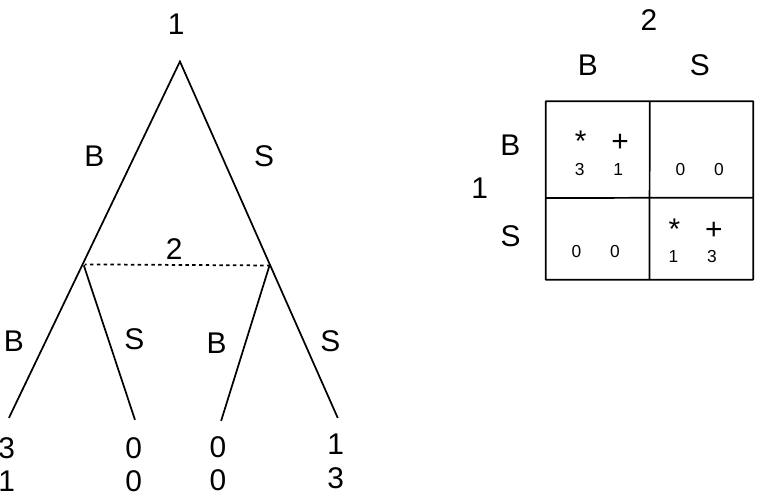
Figure 6. Battle of the sexes.